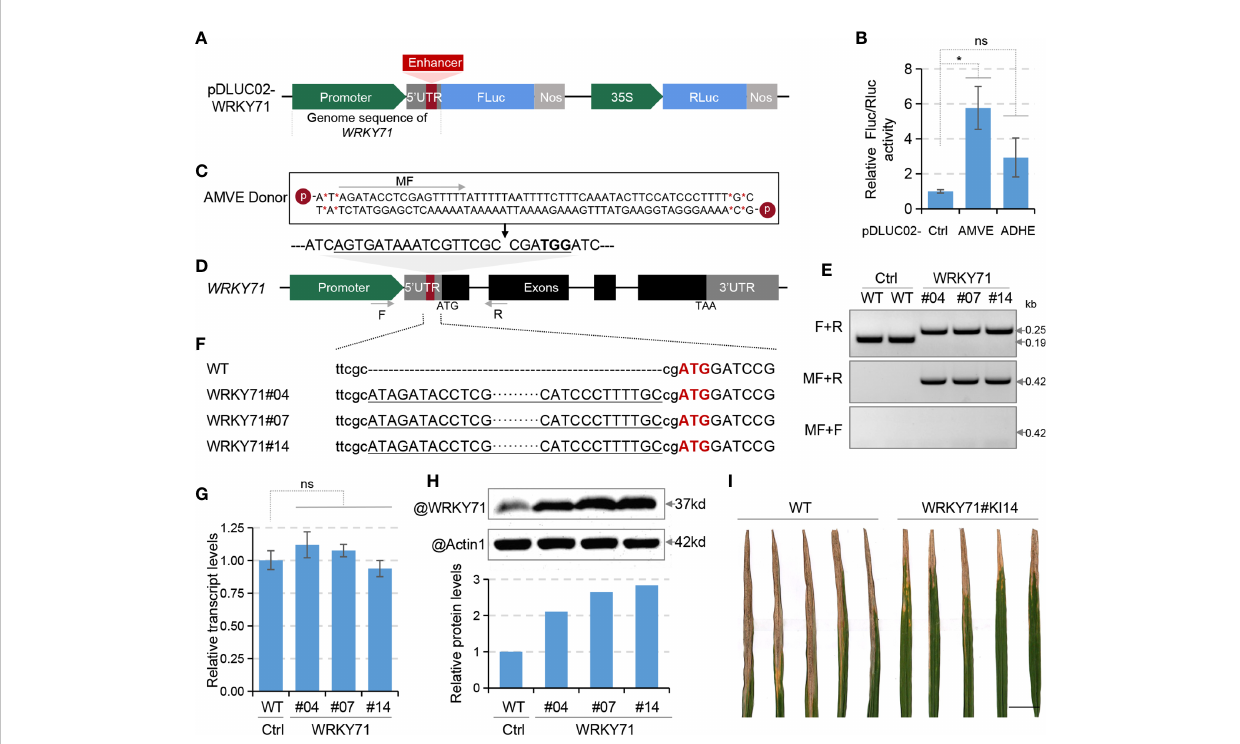
FIGURE 2 Translational enhancement of WRKY71 . (A) Schematic diagram of dual-luciferase plasmid for WRKY71 (pDLUC02-WRKY71). (B) Assessment of enhancers ADHE and AMVE in protoplast-based dual-luciferase assays. Plasmids pDLUC02-WRKY71 with or without (Ctrl) enhancer sequences were used as reporters. (C) The chemically modi fi ed donor sequence of AMVE. (D) Schematic diagram of WRKY71 for AMVE knock-in. The sgRNA target of Cas9 is underlined with the protospacer-adjacent motif (PAM) in bold. (E) Genotyping of AMVE knock-in mutants on WRKY71 with PCR. Genomic DNA was ampli fi ed using primers fl anking target sites (F+R). Forward (middle) and reverse (lower) insertion mutants were identi fi ed using primers F +MR and F+MF, respectively. Positions of primers are indicated as arrows in (C, D) . (F) Sequencing results of AMVE knock-in mutants. Sequences of AMVE were underlined and the start codon of WRKY71 is in red. (G) Transcription levels of WRKY71 in WT (Ctrl) and T1 mutants were determined using qRT-PCR. The rice Actin1 gene was used as the internal control. (H) Comparison of the protein level of WRKY71 between the WT (Ctrl) and T1 mutants. Actin1 was used as the loading control in the immunoblot assay. The ratio of the gray value (WRKY71/Actin1) was calculated using ImageJ. (I) Representative results of lesion length symptoms caused by Xoo strains in rice leaves. Photograph was taken two weeks after inoculation with PXO99. Bar, 2 cm. (B, G) All values represent means ± s.d. of three independent experiments (n = 3). * P < 0.05; ns, no signi fi cant difference (two- tailed Student ’ s t